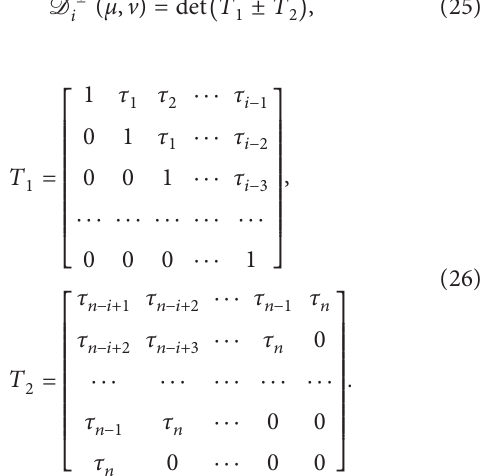
Figure 2: Topological classification for E